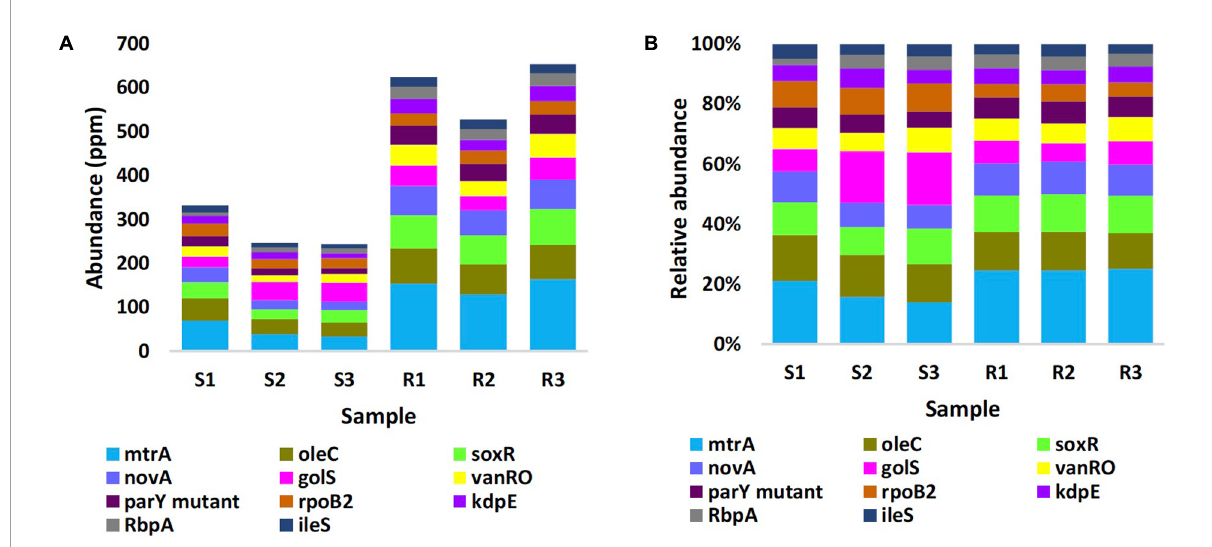
FIGURE3 Abundance in unit ppm (A) and relative abundance (B) of the top highly abundant antibiotic resistance genes ( > 20 ORFs/ARG) in different samples of rhizobiomes (Rl–R3) and bulk soil (Sl–S3) microbiomes surrounding Moringa oleifera. Unit ppm was calculated by magnifying 10 6 times of the original abundance data. Box colors of other ARGs match those of Figure 4